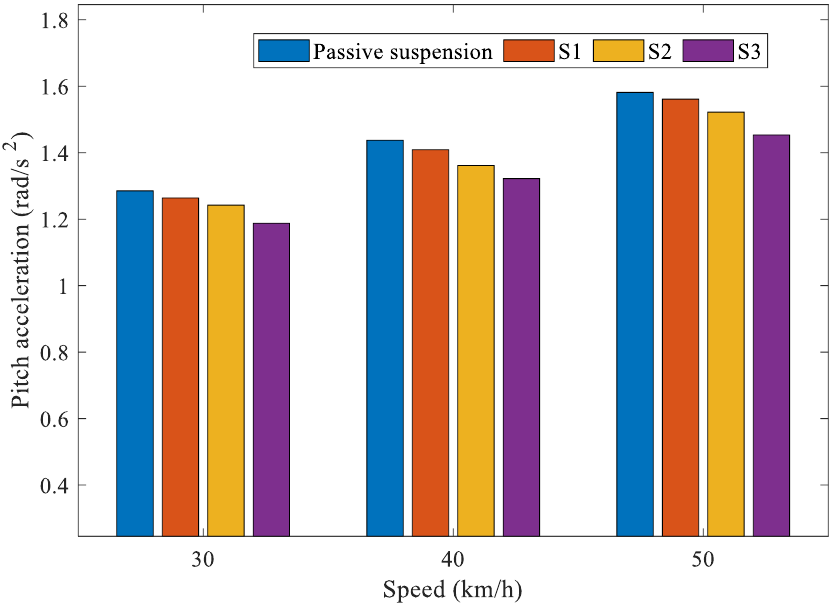
Figure 9. Comparison of the RMS of pitch acceleration under different speeds.